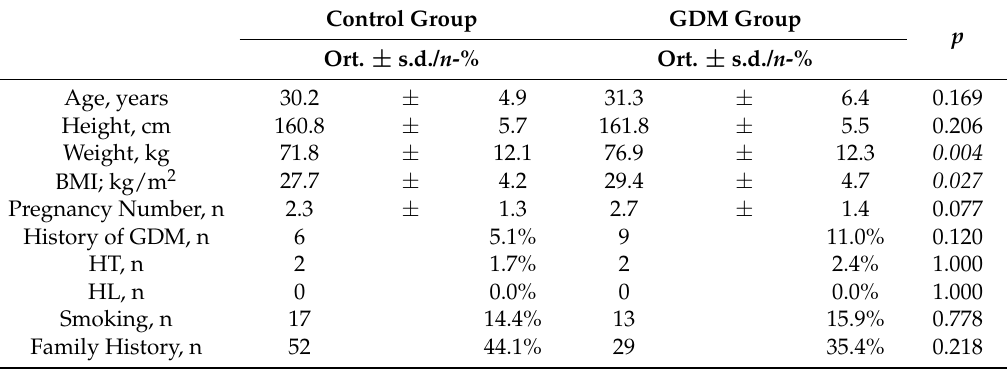
Table 1. Demographic characteristics of the gestational diabetes mellitus (GDM) and control